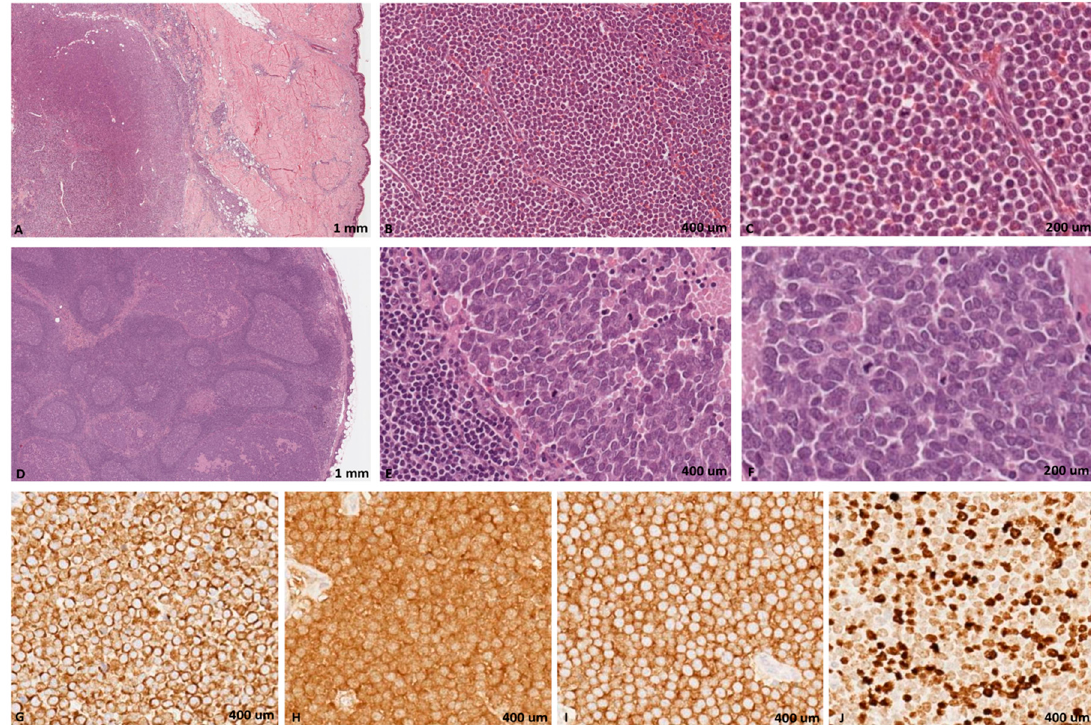
Figure 1. Merkel cell carcinoma. A malignant blue cell tumor nodule in dermis and adipose tissue of subcutis ( A ) and lymph node epithelial metastasis ( D ). Both in subcutaneous ( B , C ) and lymph nodal ( E , F ) sides, there is a proliferation of intermediate round tumor cells with fine granular chromatin and nuclear molding ( H , E , A , D 5×; B , E 20×; C , F 40×). The tumor cells are positivity for CK20 ( G ), synaptophysin ( H ) and CD56 ( I ), with high proliferation index ( J , Ki67 of about 70%) ( G – I immunohistochemical staining, 40×).